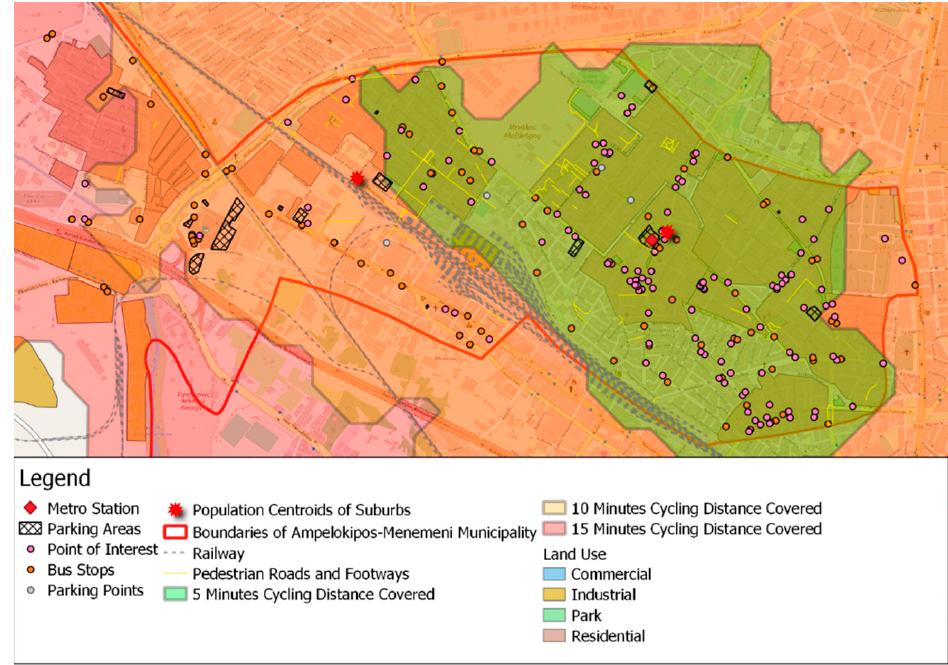
Figure 5. Walking distance of 5 min, 10 min, and 15 min from the metro (Background map: © Open- StreetMap contributors [88]).